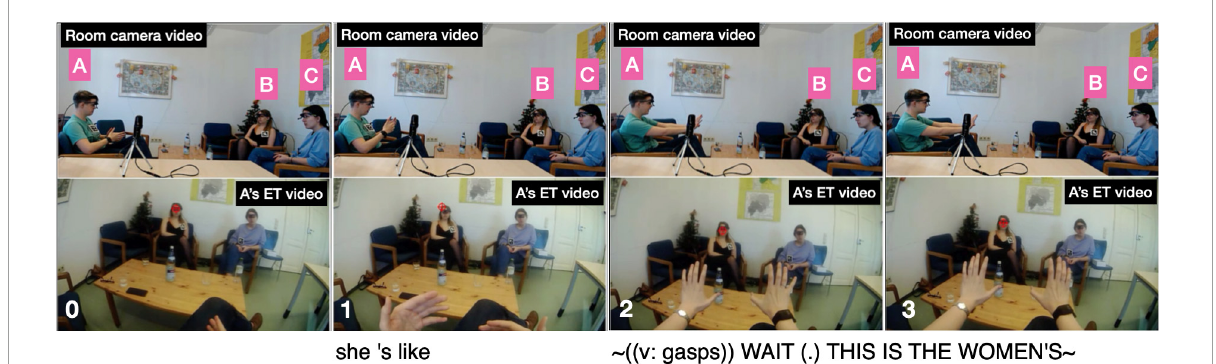
FIGURE12 Storyteller A’s gesture during “she’s like ∼ (v: gasps) WAIT (.) THIS IS THE WOMEN’S ∼ ”.